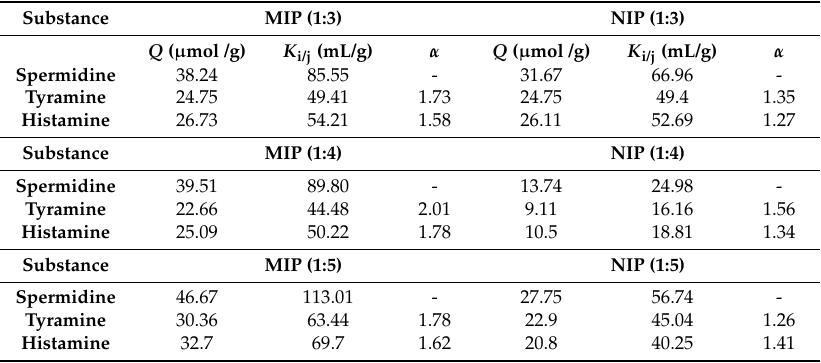
Table 4. Distribution coefficient K and selectivity factor α of